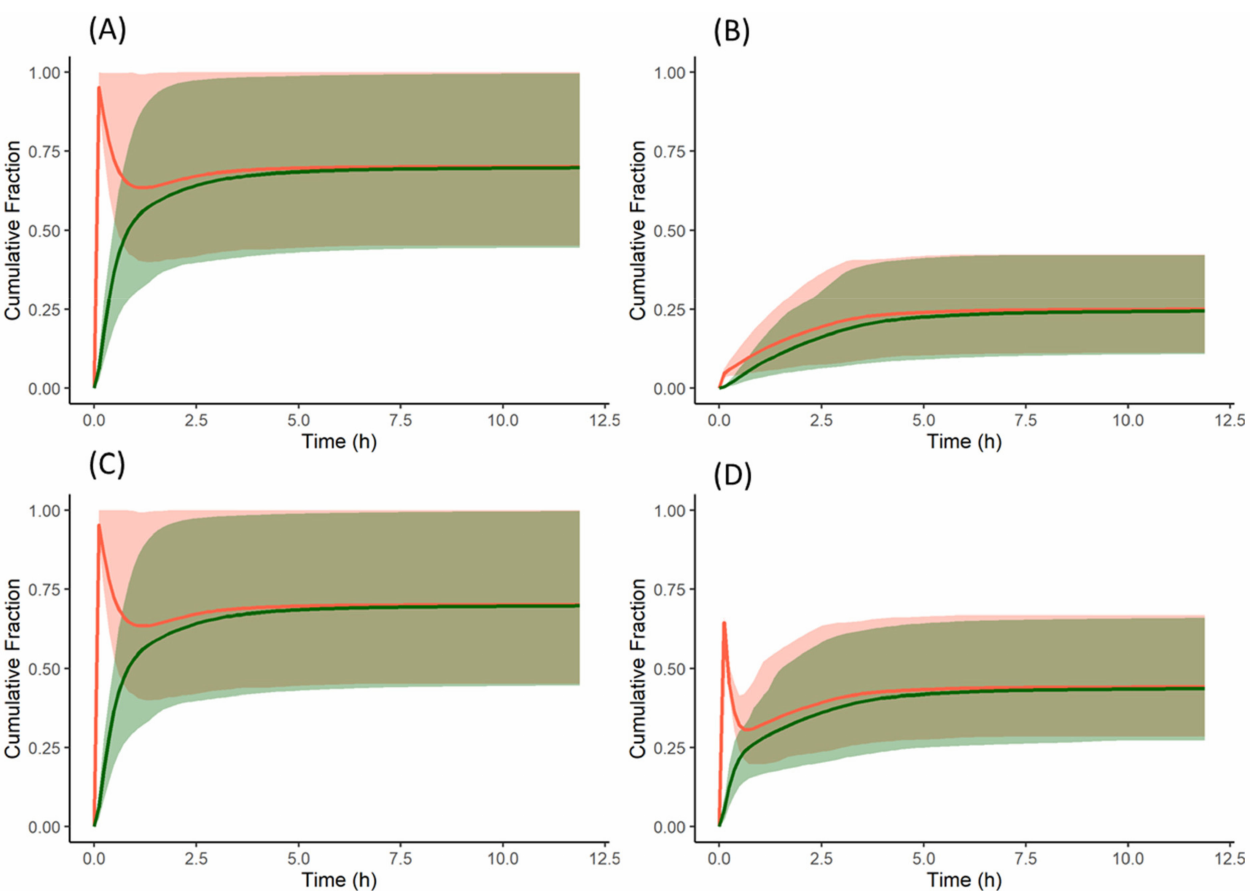
Figure 8. Cumulative fraction of dose dissolved (red) and cumulative fraction of dose absorbed (green) profiles of the model compound: ( A ) free form without famotidine, ( B ) free form with famotidine, ( C ) salt form without famotidine, and ( D ) salt form with famotidine. Solid lines represent the mean and shaded area represent 5th and 95th percentiles of individual profiles. A reduction in the % dissolved reflects precipitation. For dispersible formulations as in this example the % dissolved reflects the net effect across all nine segments of the ADAM